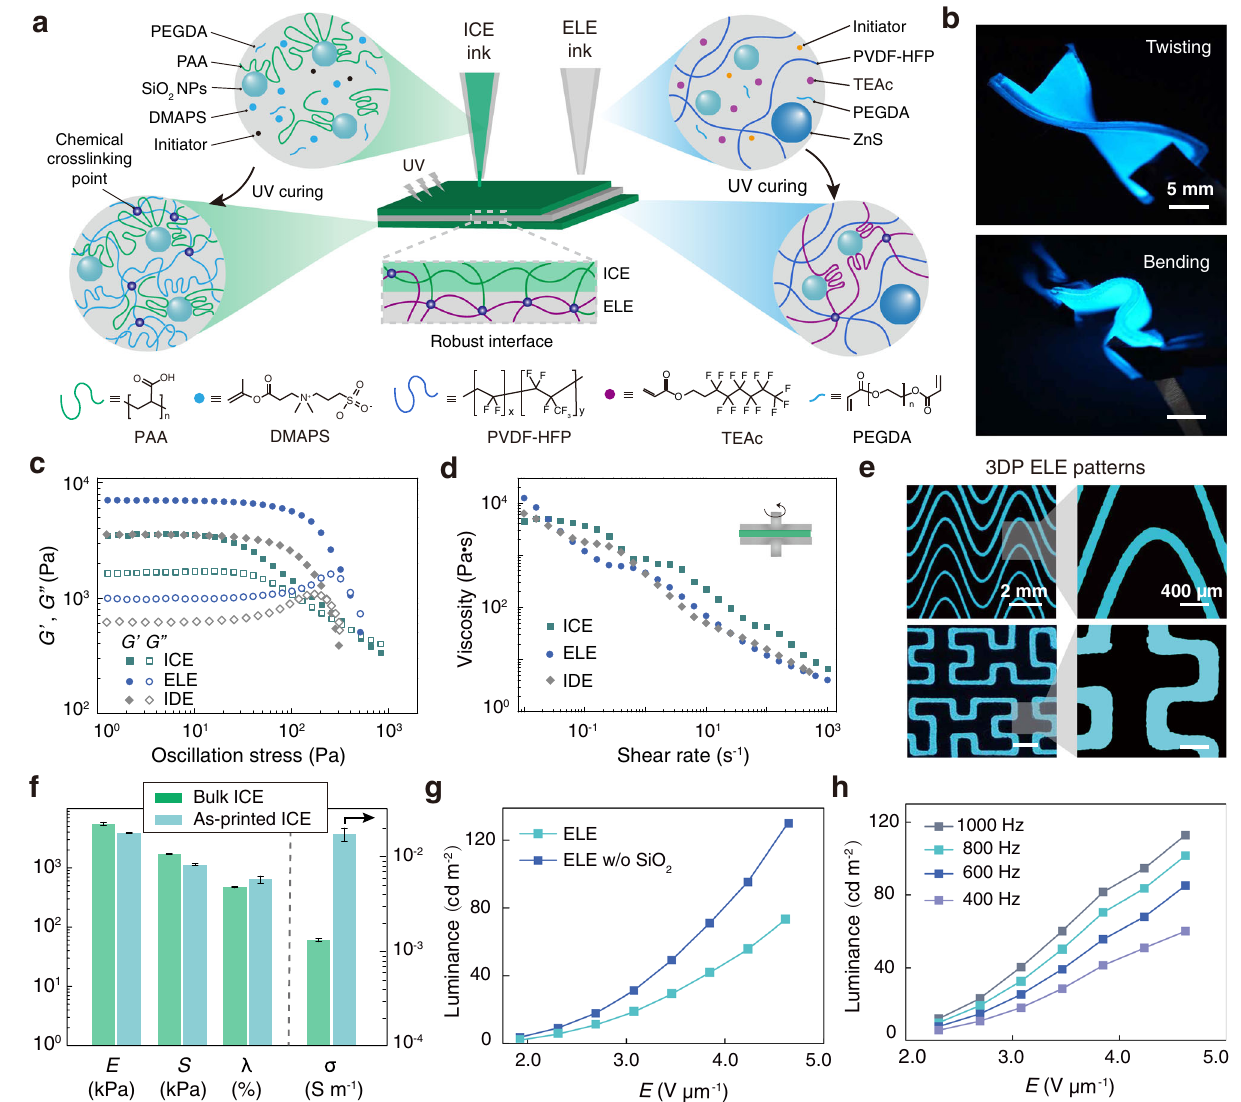
Fig. 2 | Ink Design for Direct Ink Writing (DIW). a Schematic illustration of the multi-materialprintingprocessforfabricatinganELdevice,whichconsistedoftwo ion conducting elastomer (ICE)layersand one electroluminescent elastomer (ELE) layer. The addition of SiO 2 nanoparticles in the inks leads to physically-crosslinked gels, which are fl uidized by the shearing force during ink extrusion and can be recovered to the gel state right after printing. Further UV-initiated polymerization of DMAPS/PEGDA or TEAc/PEGDA leads to the formation of an intact network structure. b Images of the 3DP EL devices under mechanical deformation (i.e., twisting and bending), which are powered with an alternating current. Scale bar: 5mm. c Shearstoragemoduli( G ')andlossmoduli( G '')oftheICE,ELE,andIDEinks as a function of shear stress at 25 ∘ C, measured under an oscillatory mode at a